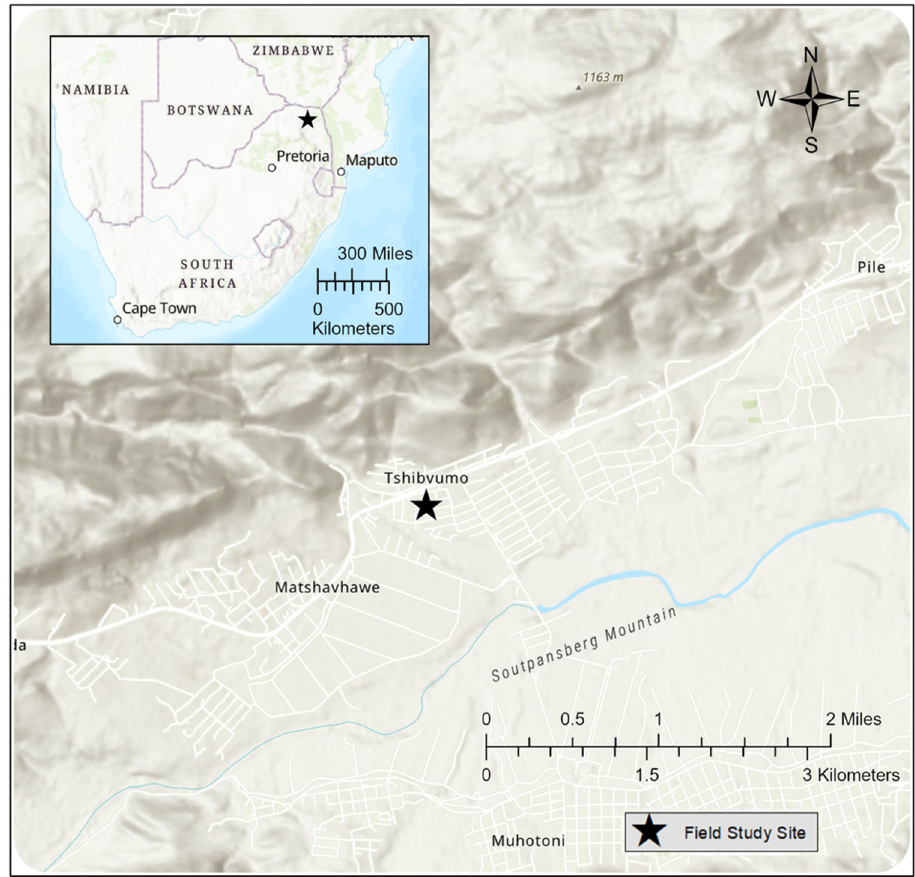
Figure 4. Map of the field study area. Sources: Esri, NASA, NGA, USGS, Garmin, FAO, NOAA, Esri South Africa, HERE, METI/NASA.